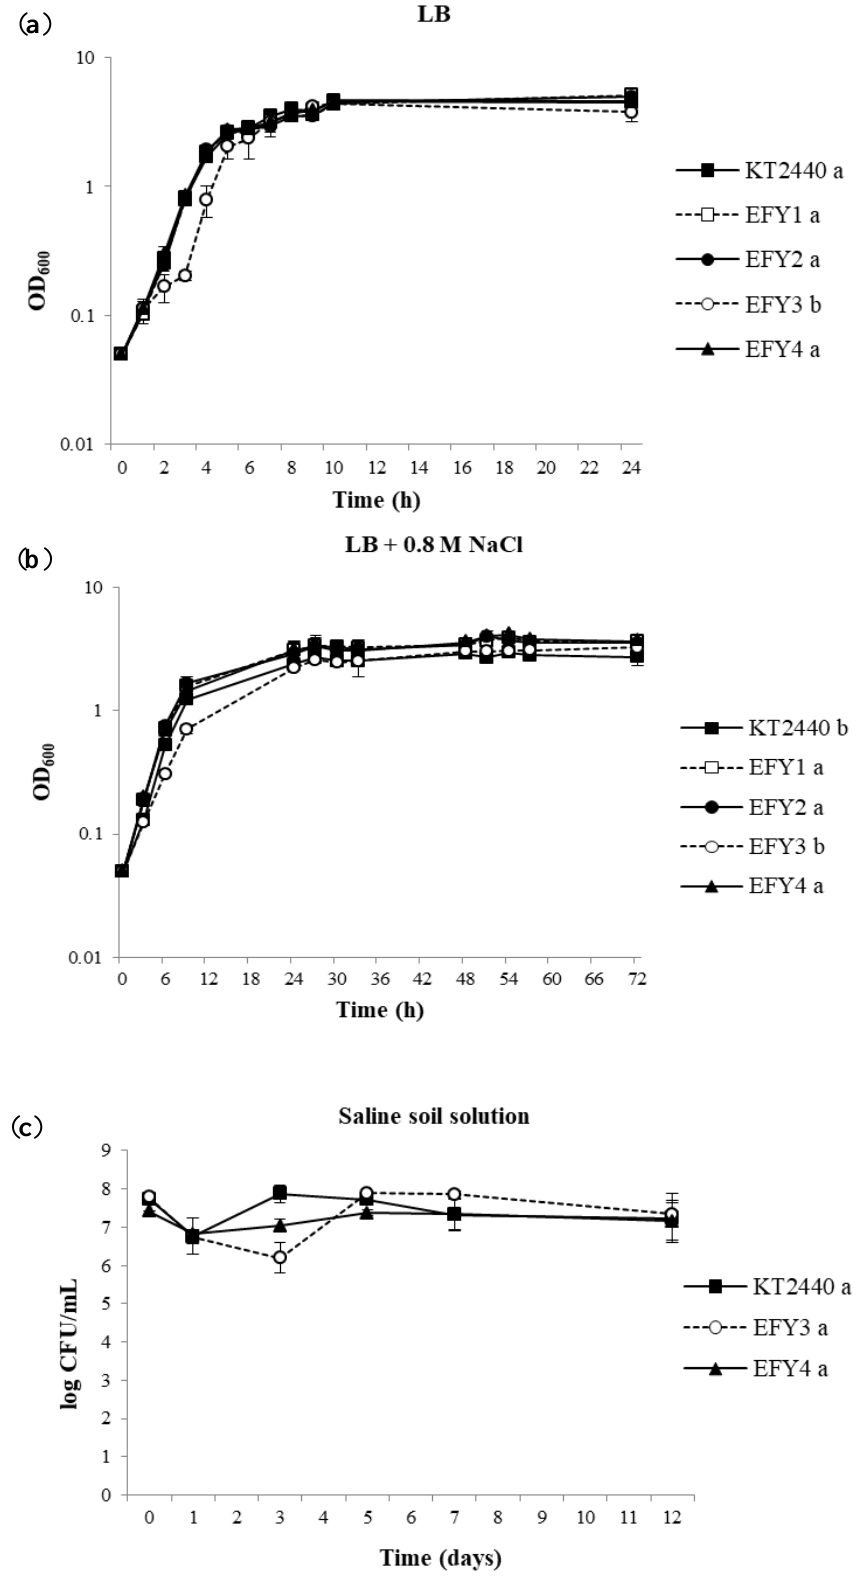
Figure 3. Growth curves in: ( a ) LB, ( b ) LB + 0.8 M NaCl, and ( c ) strongly saline soil solution. Evaluated strains: ( ■ ) P. putida KT2440, (□) EFY1, (●) EFY2, ( ○ ) EFY3, and ( ▲ ) EFY4. Data are plotted as mean values ± standard error. Different letters indicate significant differences among the kinetics of the growth curves ( p < 0.05, Tukey ’ s test).